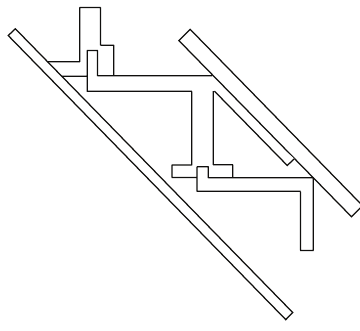
Figure 1: Solar system with Fresnel lenses.